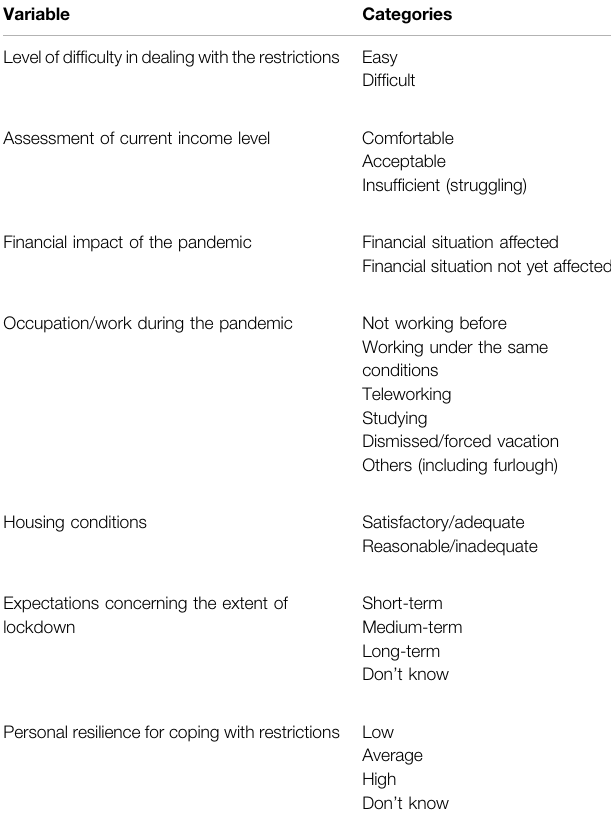
TABLE 2 | Variables included in clustering of social impacts of the